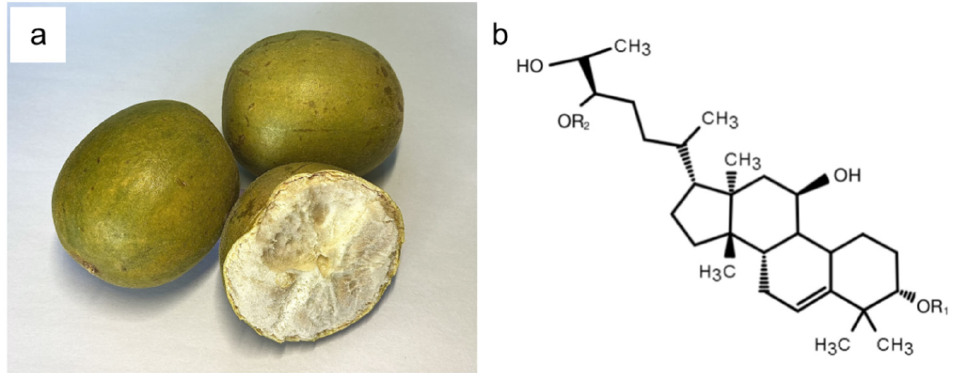
Figure 1. The fruit of Momordica grosvenorii ( a ) and the chemical structure of MGS ( b ). Therefore, the objectives of this work were to: (1) optimize the parameters of MGS encapsulated by sodium alginate and chitosan; (2) analyze the antioxidant capacity and content of MGS after embedded; (3) evaluate the potentials of the embedded MGS in stimulated gastrointestinal tract system as well as one MGS-based